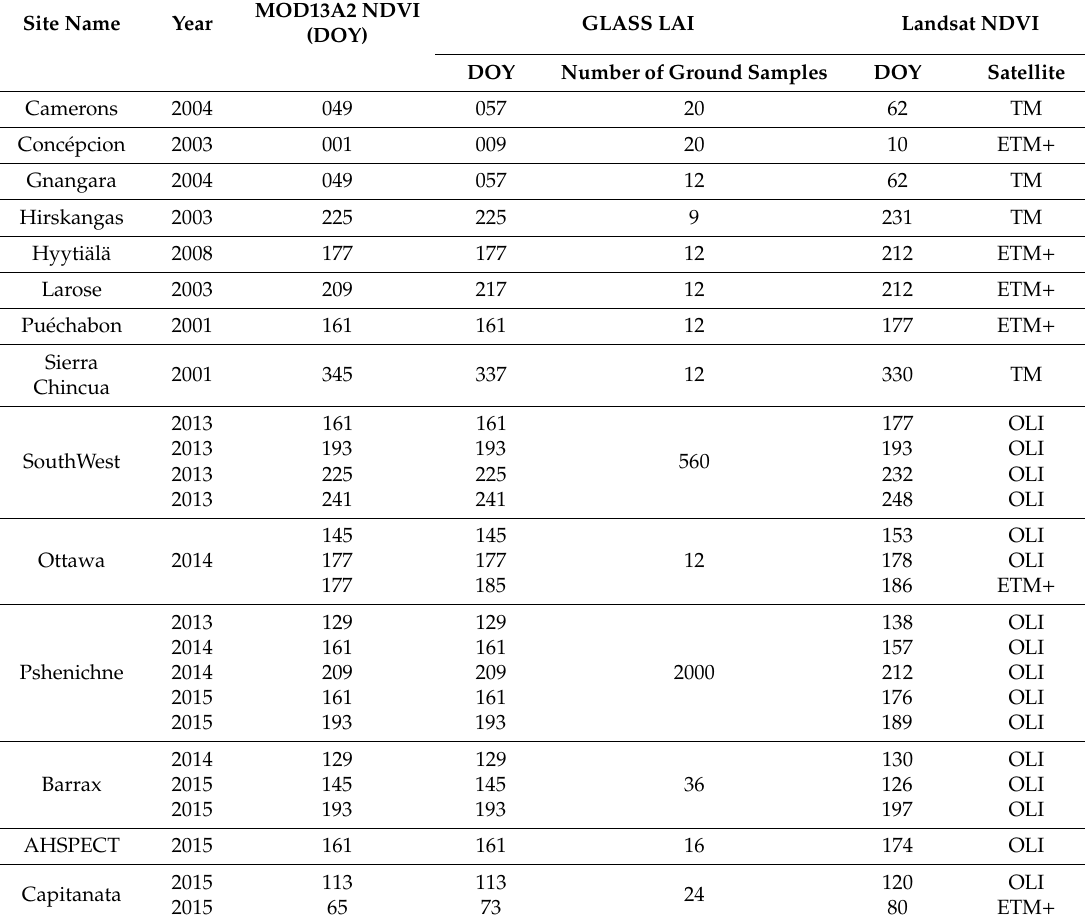
Table 2. The satellite imagery information used in this